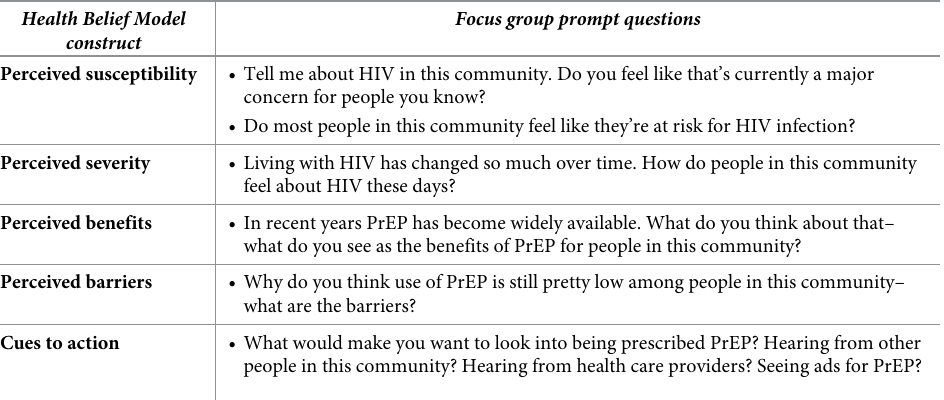
Table 1. Virtual focus group questions derived from theoretical